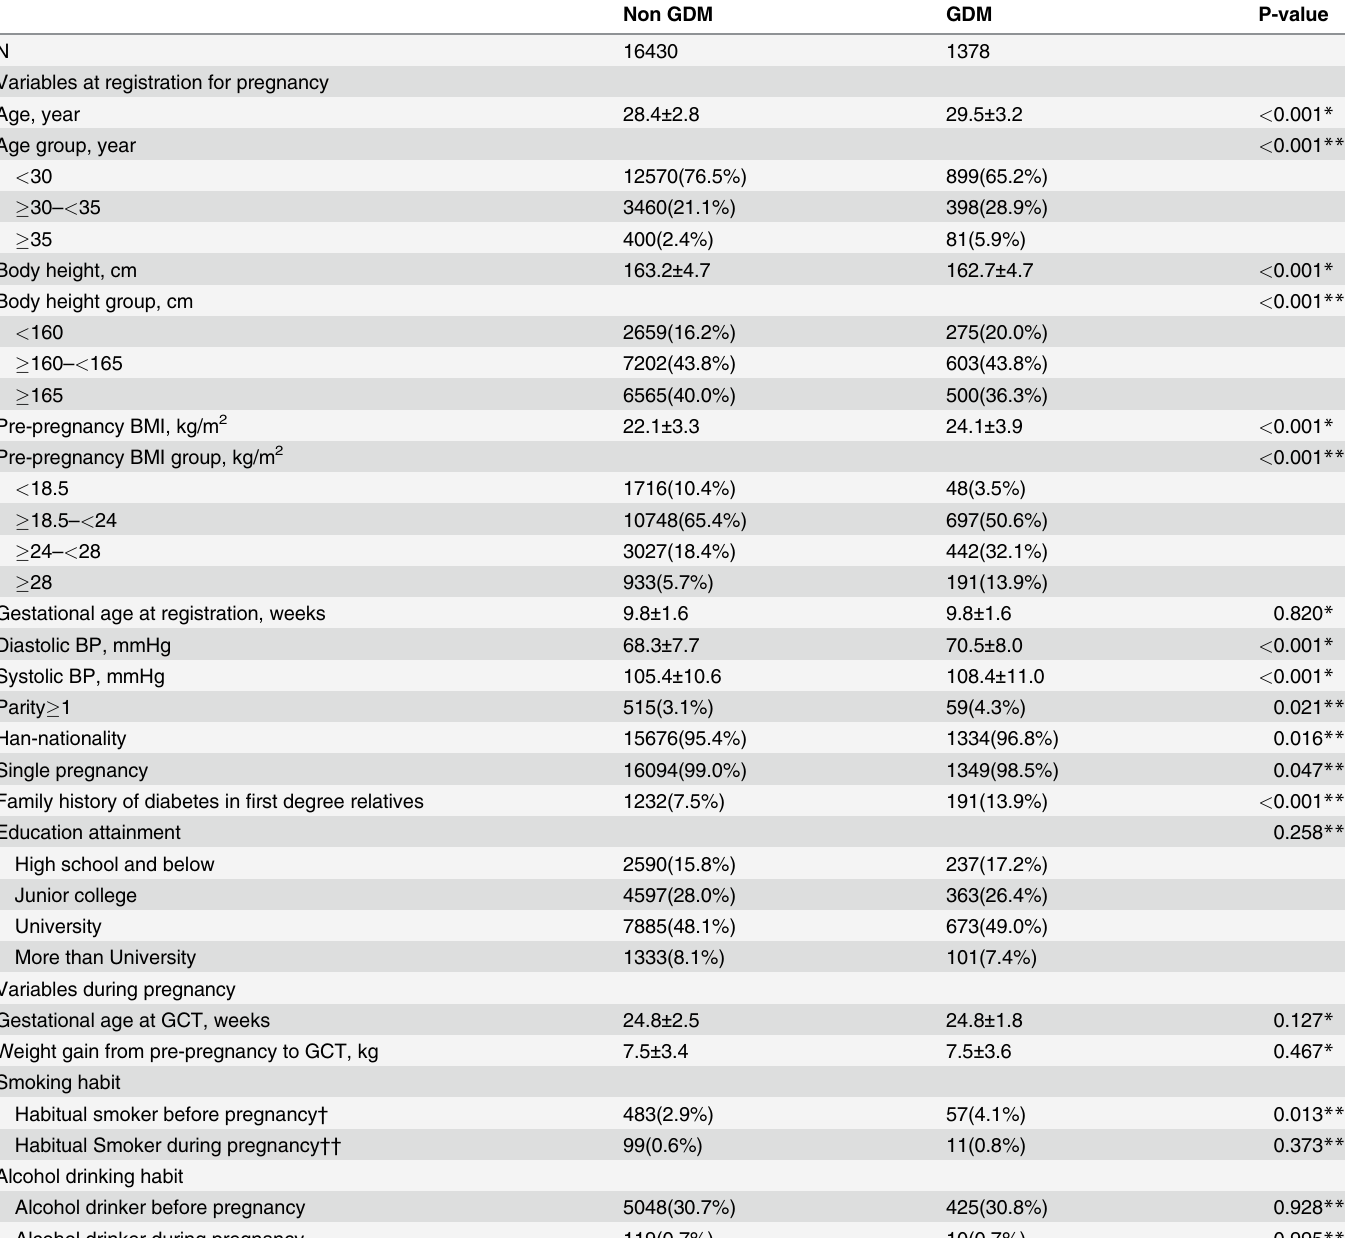
Table 2. Clinical and biochemical characteristics of subjects stratified by gestational diabetes mellitus diagnosed by the IADPSG